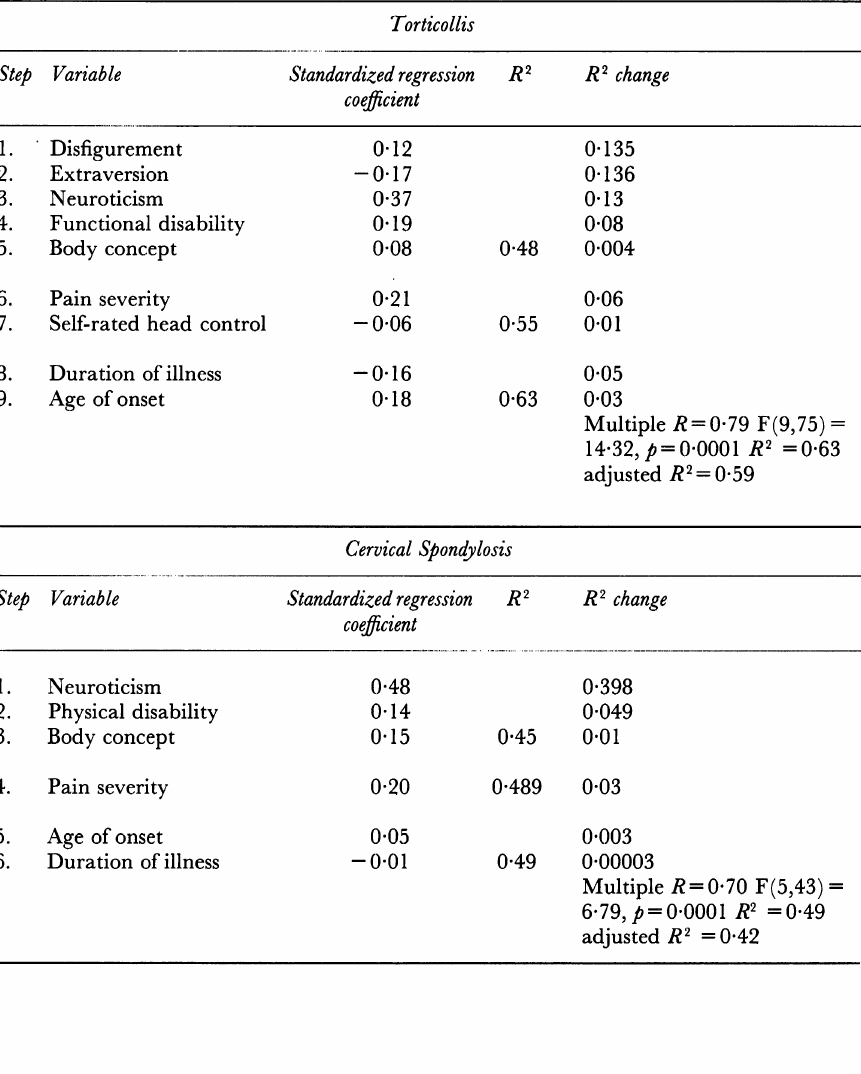
TABLE 3. Results oj the hierarchical multiple regression analyses performed to identify the best set of predictors of the total depression score in the torticollis and the cervical spondylosis group